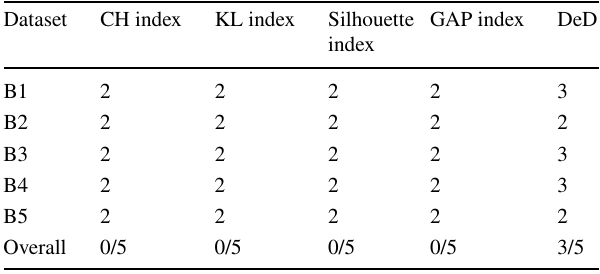
Table 3 Simulation study on synthetic datasets with inclusion of 2 unrelated variables Dataset